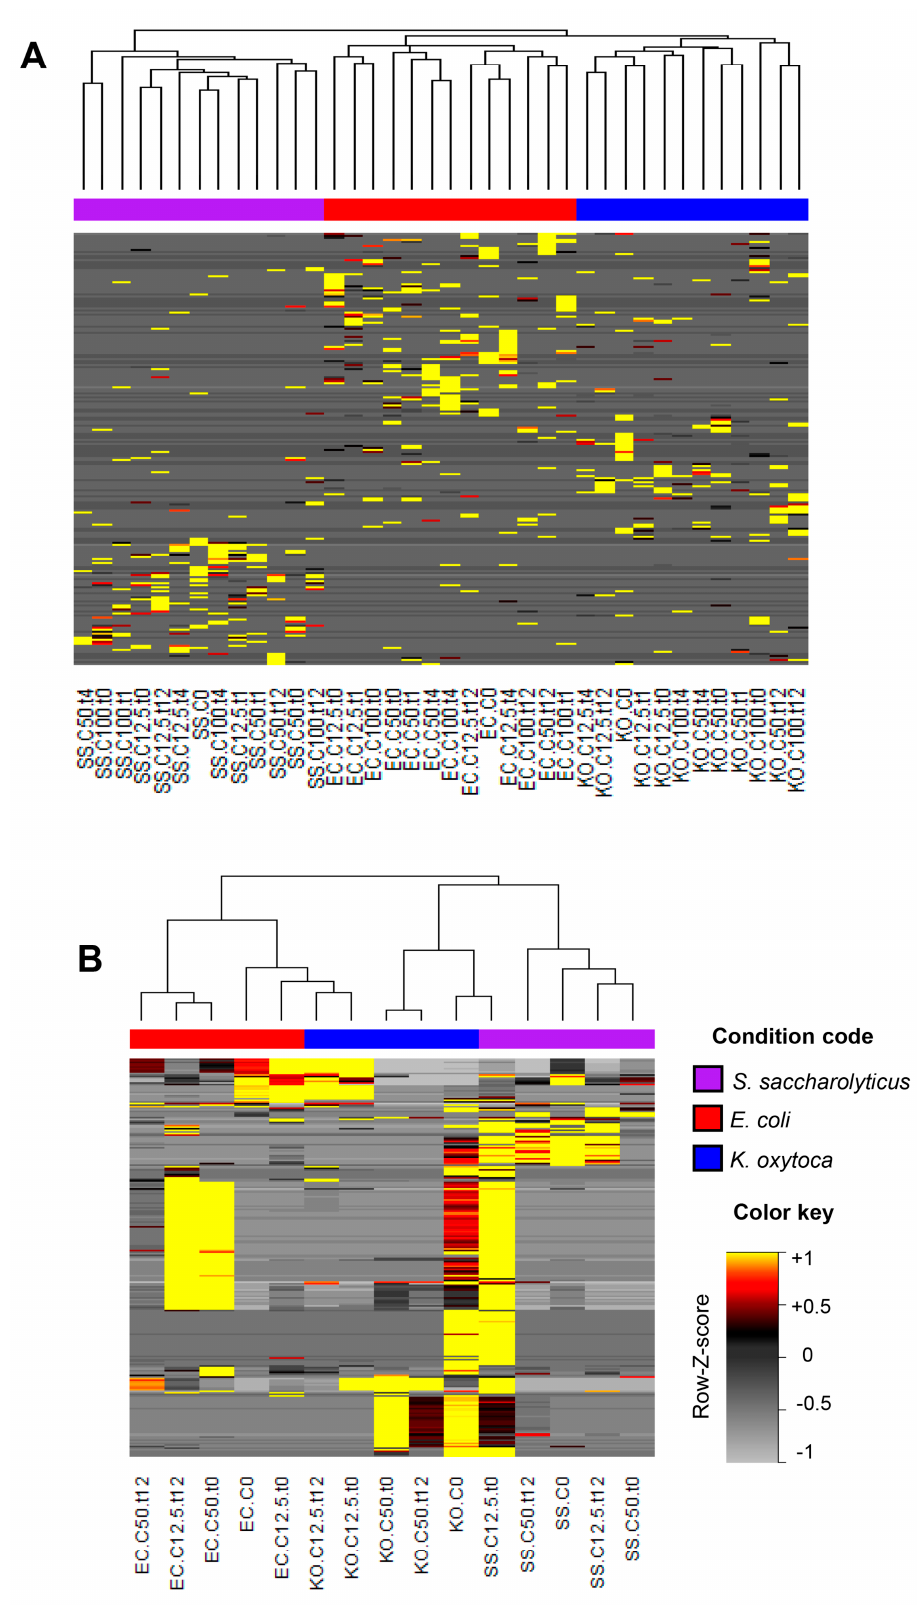
Figure 4. Heatmaps and hierarchical cluster analysis of protein ions ( A ) and volatile organic compound (VOC) profiles ( B ), based on ion areas extracted from MALDI-TOF MS spectra and GC-MS chromatograms, respectively; Horizontal axis = conducted assays, using different bacterial strains, vertical axis = ions organized in clusters.